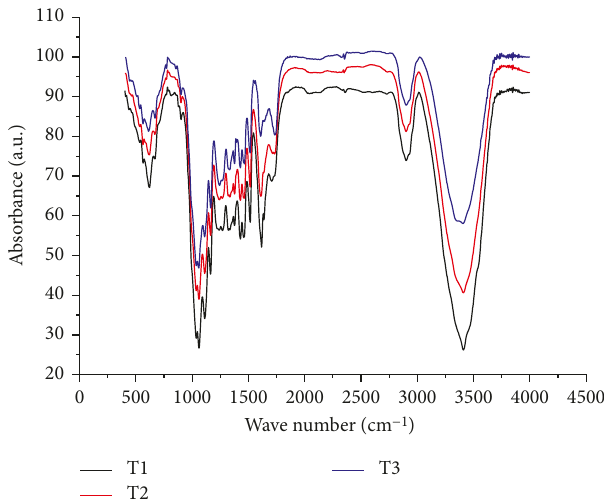
Figure 2: The FTIR spectra of specimens that had initial 30% MC and were heat treated at various temperatures: (T1) 220 ° C, (T2) 200 ° C, and (T3) 180 ° C.